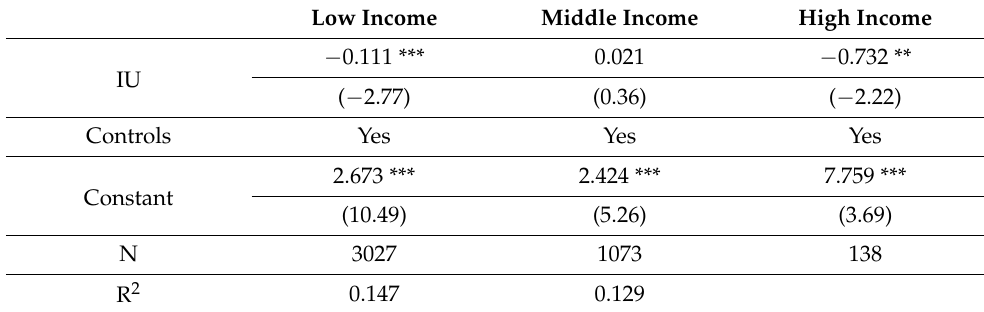
Table 6. Heterogeneous effects (2SLS).